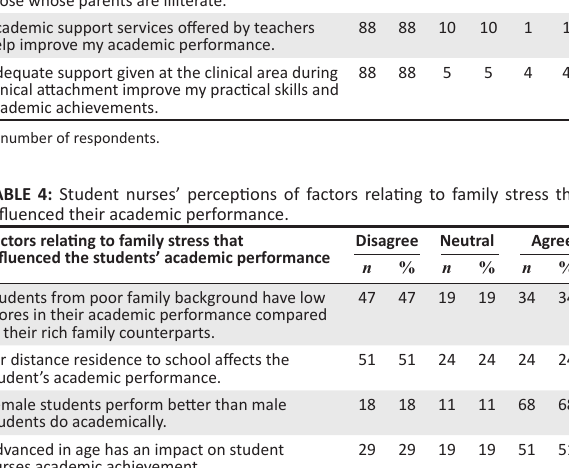
TABLE 3: Student nurses’ perceptions of factors relating to proper guidance that influenced their academic performance. Factors relating to proper guidance that Disagree Neutral influenced the students’ academic performance Parents’ involvement in the education of their children is a good predictor of better academic performance of students.